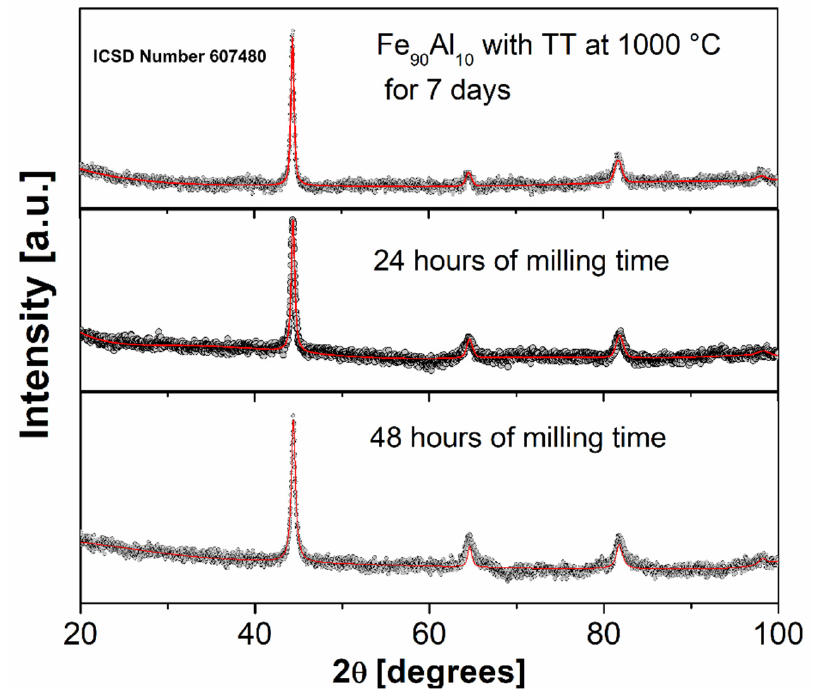
Figure 1. XRD of the Fe 90 Al 10 system with thermal treatment (TT) at 1000 °C for 7 days and mechanically alloyed with oleic acid as a surfactant for 24 and 48 h,